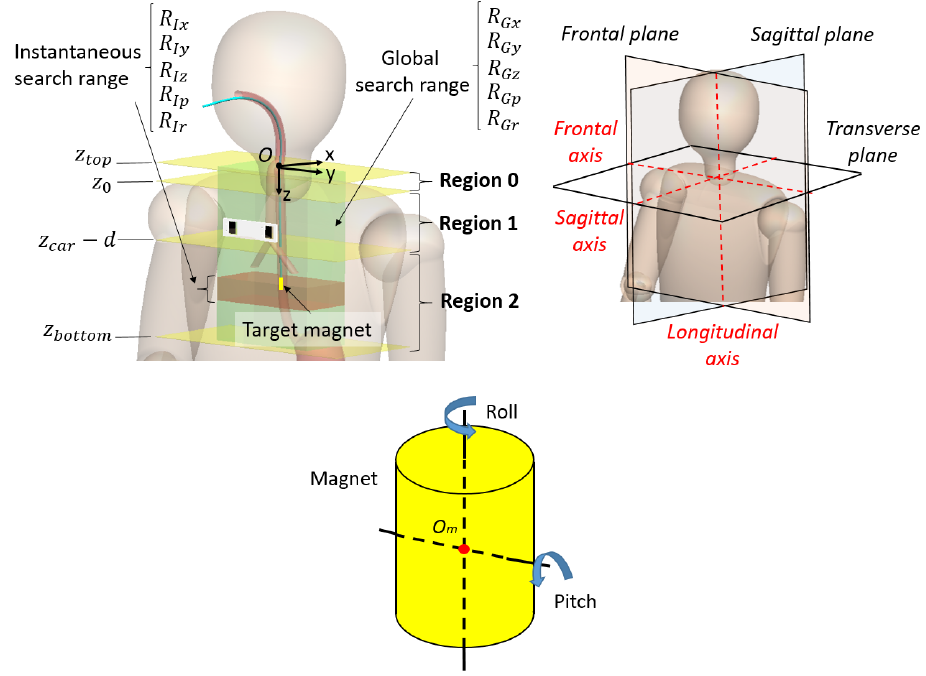
Figure 3. Top: Illustration of the search regions, global search range, and instantaneous search range. Bottom: Definition of pitch and roll rotations and the origin of the magnet ( O m